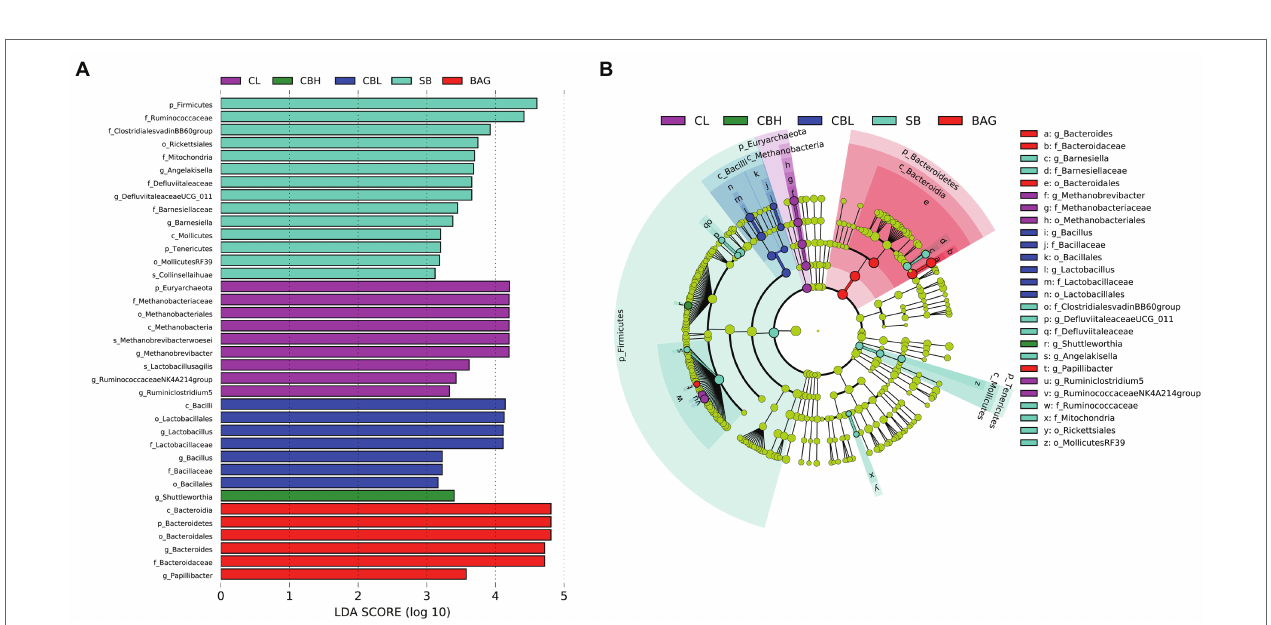
FIGURE 3 | Relative abundance of gut microbiota. (A) Relative abundance of gut microbiota at phylum level. (B) Relative abundance of Clostridium and Bacillaceae .